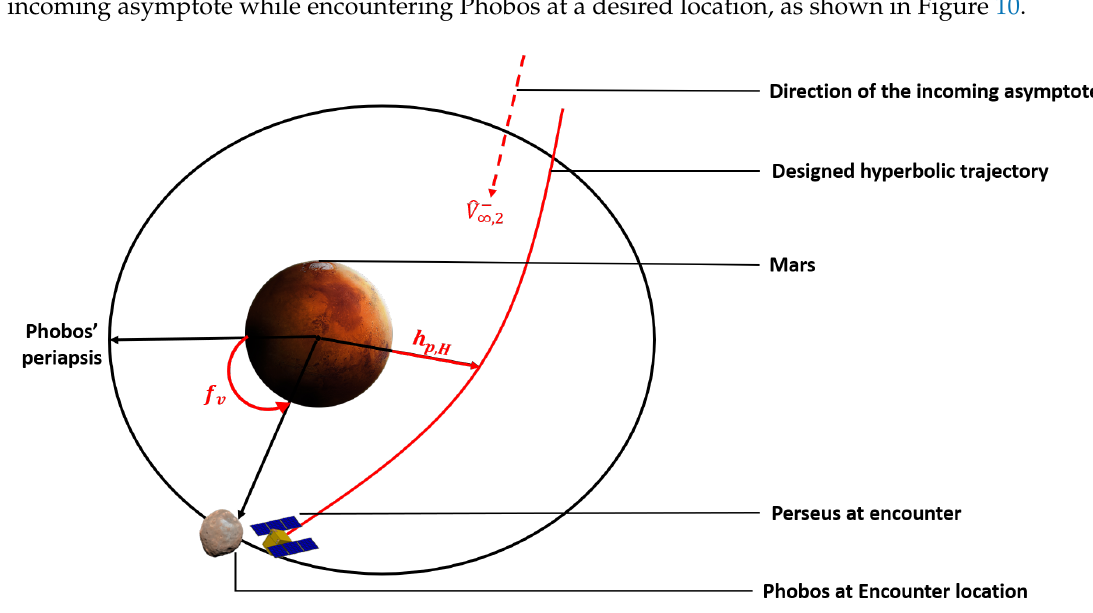
Figure 10. Illustration of the hyperbolic mission concept highlighting the parameters involved in designing the encounter hyperbolic